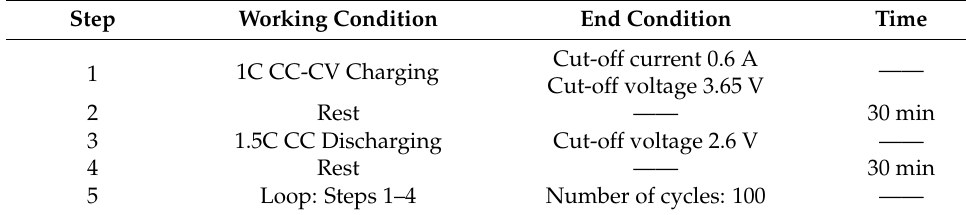
Table 2. Cyclic charging and discharging Table 1. Cell number and corresponding thermal gradient.